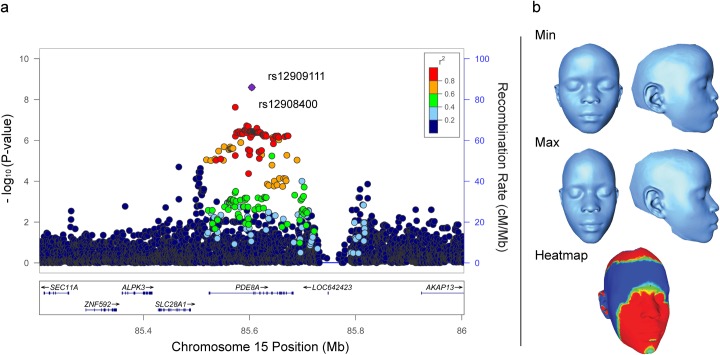
PDE8A locus associated with allometry.(A) Regional association plot of the allometry variable at the PDE8A locus. Association data are shown using GWAS P-values with the meta-analysis P-values for the two lead SNPs, rs12909111 and rs12908400. See Fig 3legend for details. (B) Morphs showing the range of allometric variation in facial shape. See Fig 4legend for heatmap details.